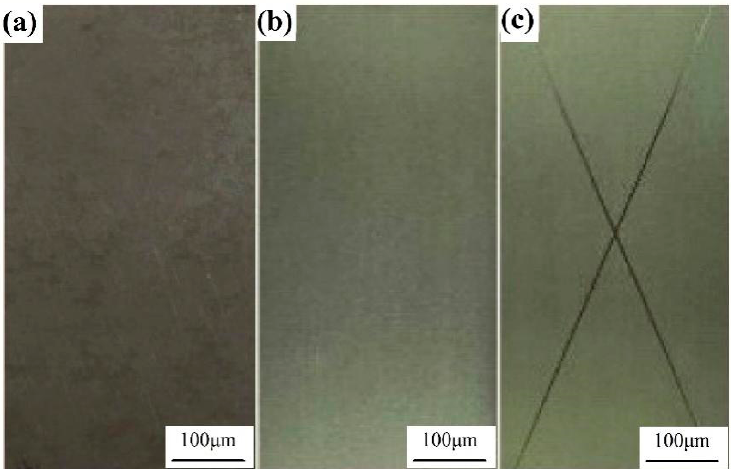
Figure 1. 5083 aluminum alloy and Al 0.7 FeCoCrNiCu 1.00 high-entropy alloy coating. ( a ) 5083 aluminum alloy; ( b ) Al 0.7 FeCoCrNiCu 1.00 high-entropy alloy coating; ( c ) cross marking on Al 0.7 FeCoCrNiCu 1.00 high-entropy alloy coating.